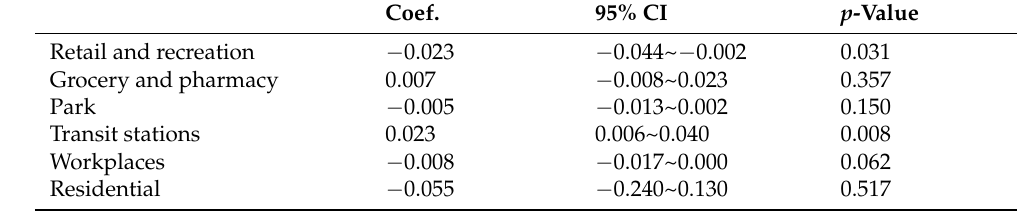
Table 3. Relationship between changes in the population flow of each place and reproduction rate (7-day rolling average).